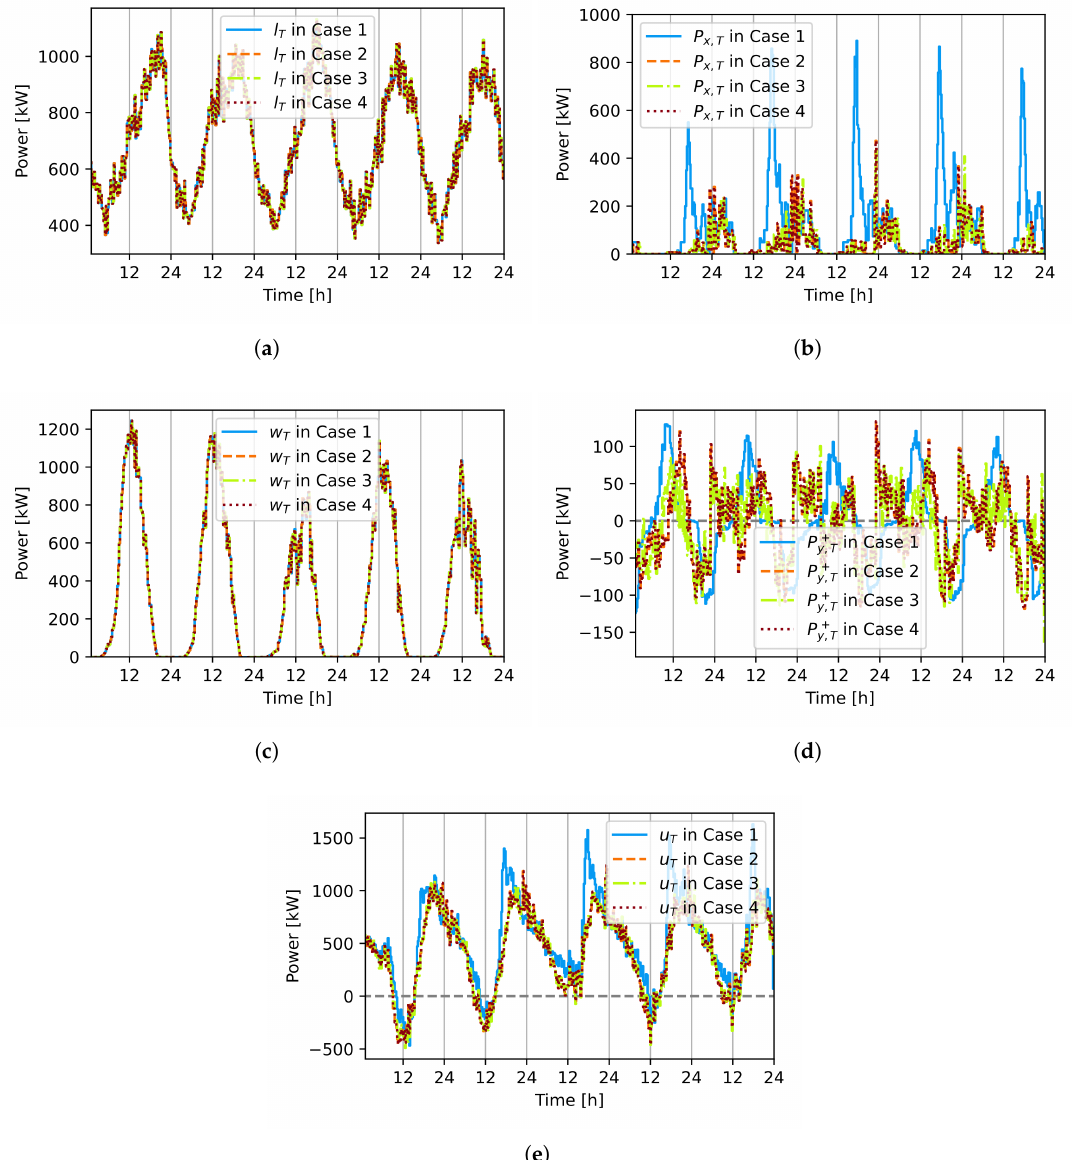
Figure 5. Total aggregator inputs, decision variables, and outputs. ( a ) Load demand (input). ( b ) EV power demand (decision variable). ( c ) PV generation (input). ( d ) Battery power exchange (decision variable). ( e ) Grid power exchange